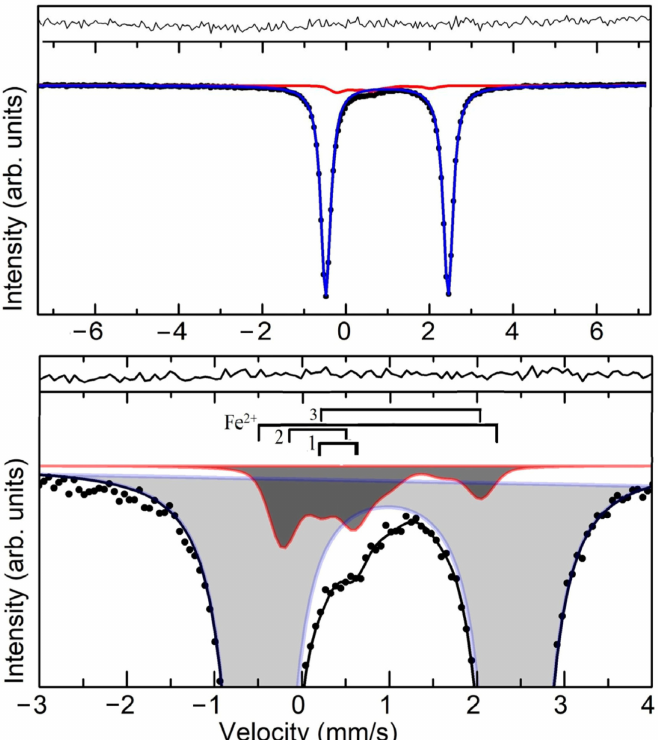
Figure 5. Experimental MS of the developed LiFePO 4 (N1) powder. Upper and lower parts—spectra are recorded with high and low speed of Doppler shift of the gamma-ray source, respectively. The best fitting results of the model spectrum are shown as a solid